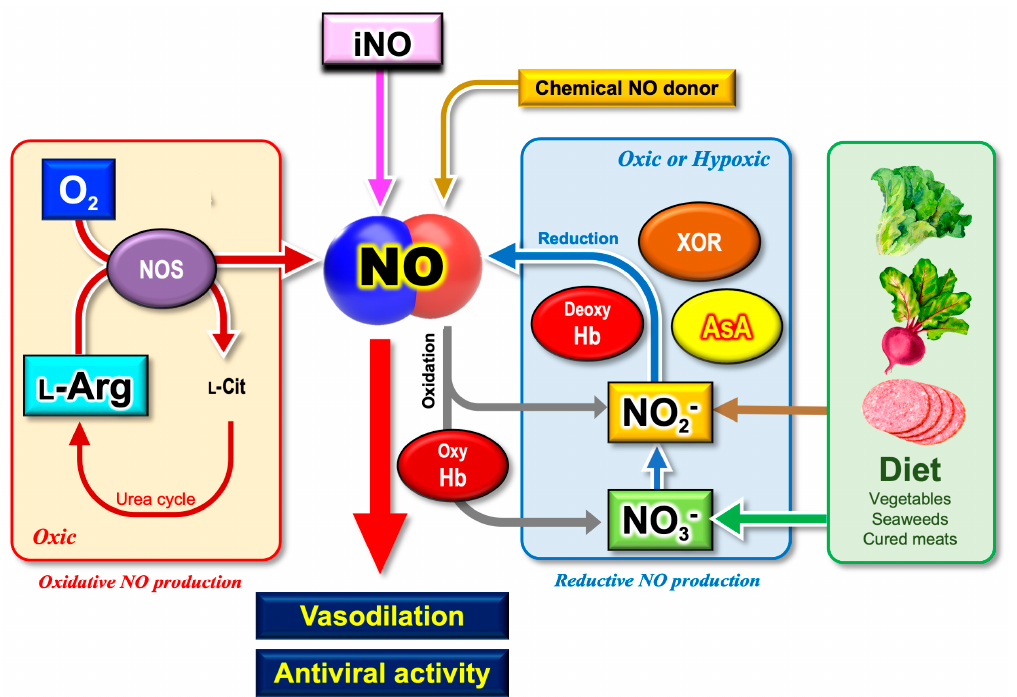
Figure 2. Diversity of NO generation mechanisms. NO displays multiple physiological functions in humans, such as vasodilation effects. It has also been suggested that NO inhibits the replication of viruses, including SARS-CoV, thereby preventing viral infection. There are two distinct mechanisms for NO synthesis, namely, NOS-dependent and NOS-independent NO generating mechanisms. Regardless of the pathways, inorganic nitrate (NO 3 − ) and/or nitrite (NO 2 − ) are produced as the oxidation product of NO. In humans, NO 3 − is supplied by daily diets, including green vegetables or seaweeds, which may help to support NO bioavailability. NO, nitric oxide; iNO, inhaled nitric oxide; NOS, nitric oxide synthase; oxy-Hb, oxy-hemoglobin; deoxy-Hb, deoxy-hemoglobin; XOR, xanthine oxidoreductase; NO 2 − , inorganic nitrite; NO 3 − , inorganic nitrate; AsA, L -ascorbic acid (vitamin C).